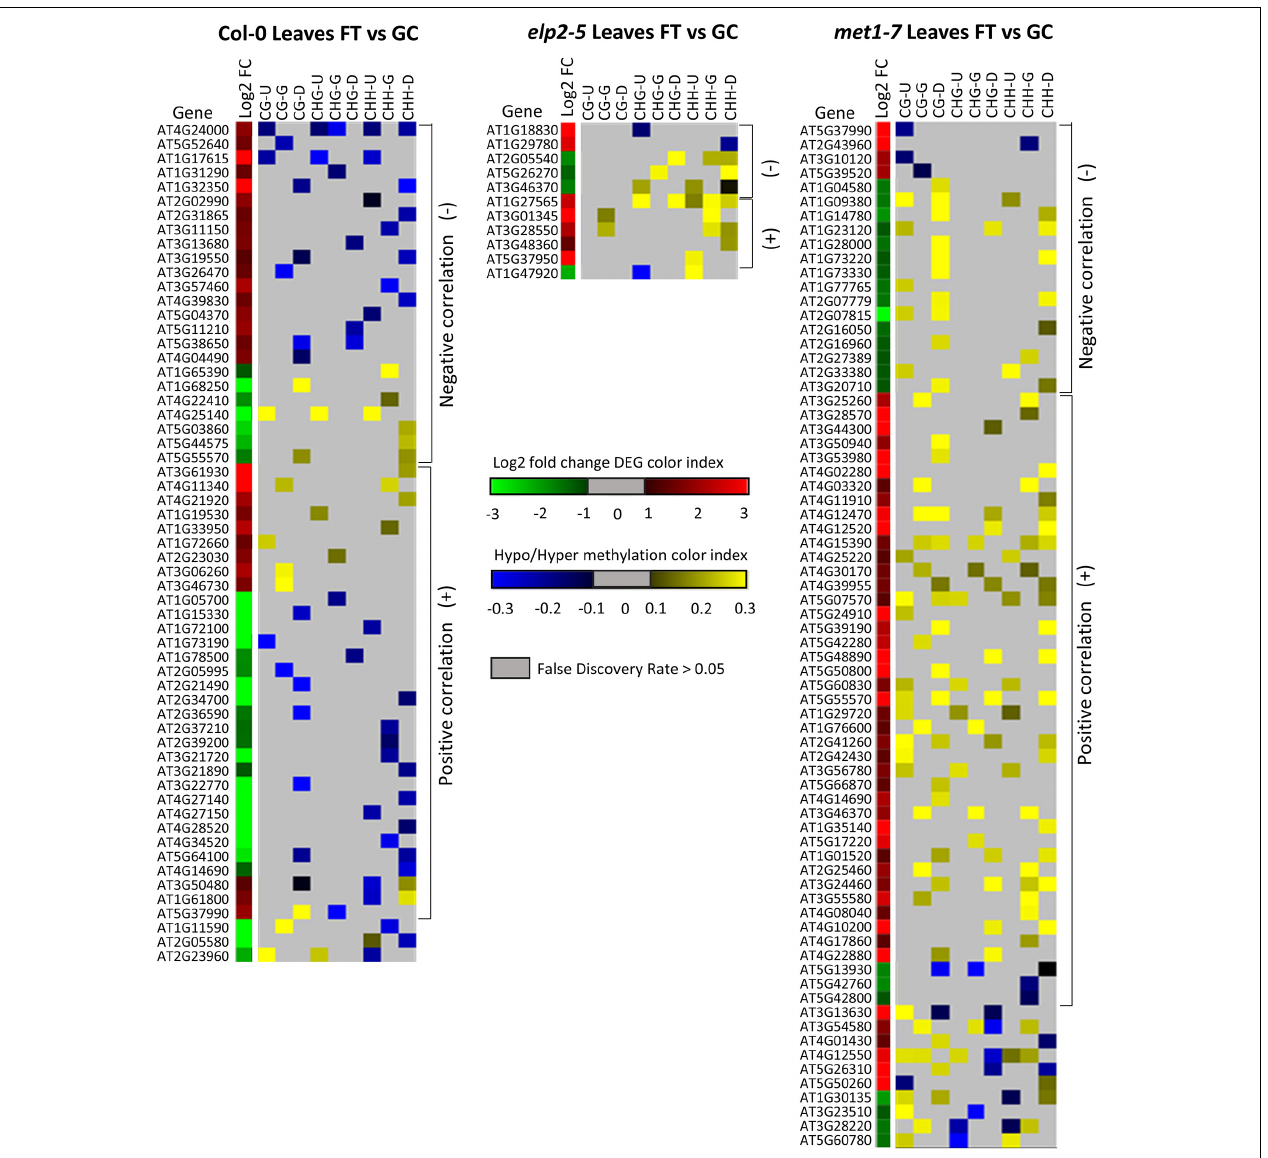
FIGURE 10 | Heatmap of spaceflight (FT) vs ground control (GC) DEGs-DmCs in Col-0, elp2-5, and met1-7 leaves. Heat maps show the Log 2 (Fold-change) of differential gene expression (red: up-regulated and green: down-regulated) and differential DNA methylation (hypermethylation: yellow and hypomethylation: blue) of Col-0, elp2-5 , and met1-7 leaves in FT compared to GC. DmCs for each CG, CHG, and CHH methylation context in each genic region (Gene body: TSS to TTS, upstream: 2 kb from TSS, downstream: 2 kb from TTS) are denoted in the heat maps. The heatmaps show both negative and positive correlations of DEGs with DmCs. Negative correlations ( − ) are defined when up-regulated genes aligned with hypomethylated DmCs and down-regulated genes aligned with hypermethylated DmCs. The converse relationship is indicative of a positive correlation